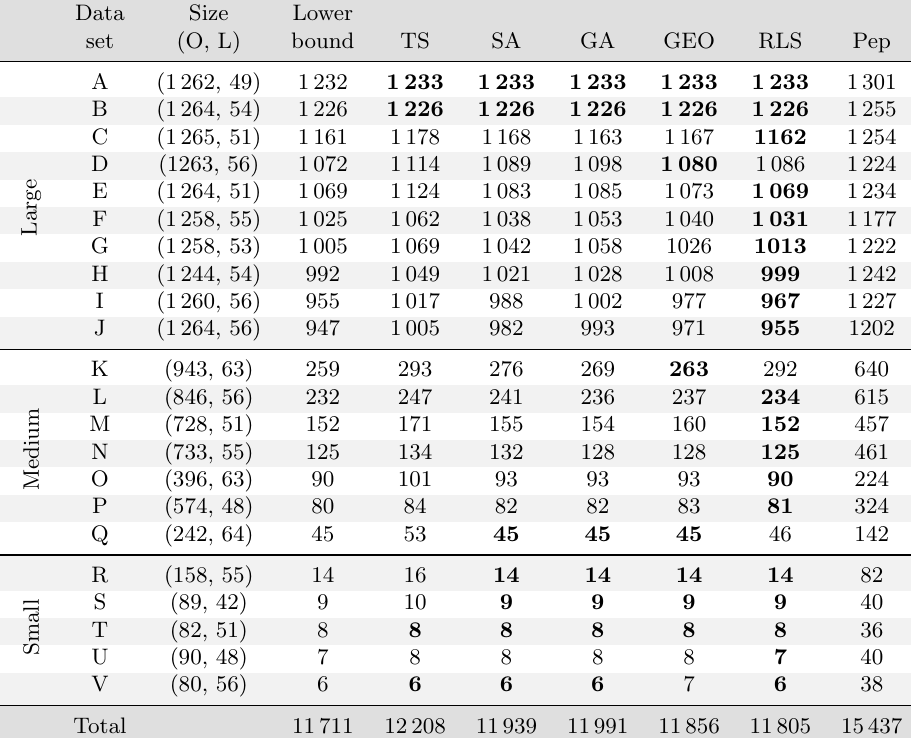
The solutions (as number of cycles travelled) for the tabu search (TS), simulated annealing (SA), genetic algorithm (GA), generalised extremal optimisation (GEO) and random local search (RLS) for each data set. The historical results from Pep are listed in the last column. The number of orders (O) and the number of locations (L) are indicated for each data set. The best solution quality for each data set is indicated in